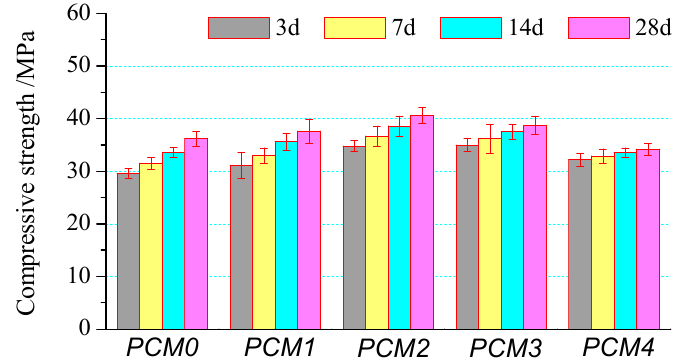
Figure 6. E ff ects of PVA content on the compressive strength of cement Figure 6. Effects of PVA content on the compressive strength of cement mortar.